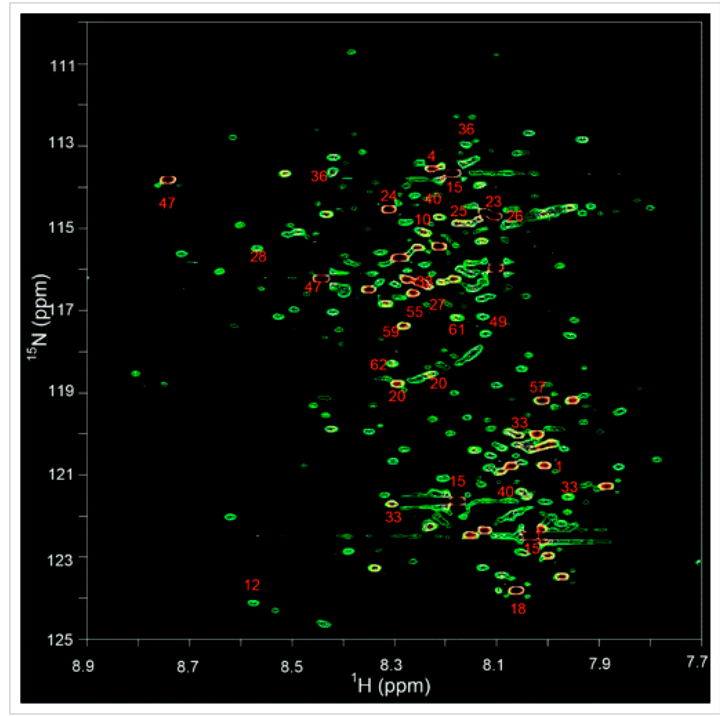
Figure 5. Detection of nearly 200 carboxyl-containing metabolites in urine by 2D 1 H- 15 N heteronuclear single quantum correlation spectroscopy (HSQC) NMR after tagging with 15 N isotope containing ethanolamine [46].